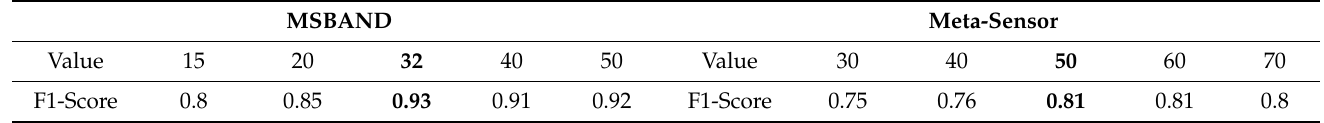
Table 1. Window_Size tuning for MSBAND and meta-sensor datasets, respectively.